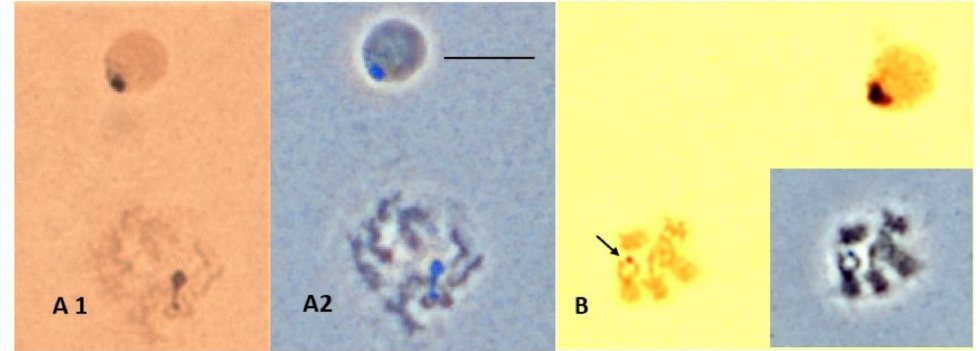
Figure 7. Silver staining technique showing Scaptodrosophila sp. aff. cancellata chromosomes. ( A ) Inter- phase and early mitotic cells with nucleolar staining. ( A1 ) Bright field. ( A2 ) Phase with distinctive coloration of nucleolus. Chromosomal origin of nucleolar fragment unknown. ( B ) Mitotic cell with silver-positive spot over apparent X chromosome. Bar = 5 µ m. Insert shows phase contrast of the same